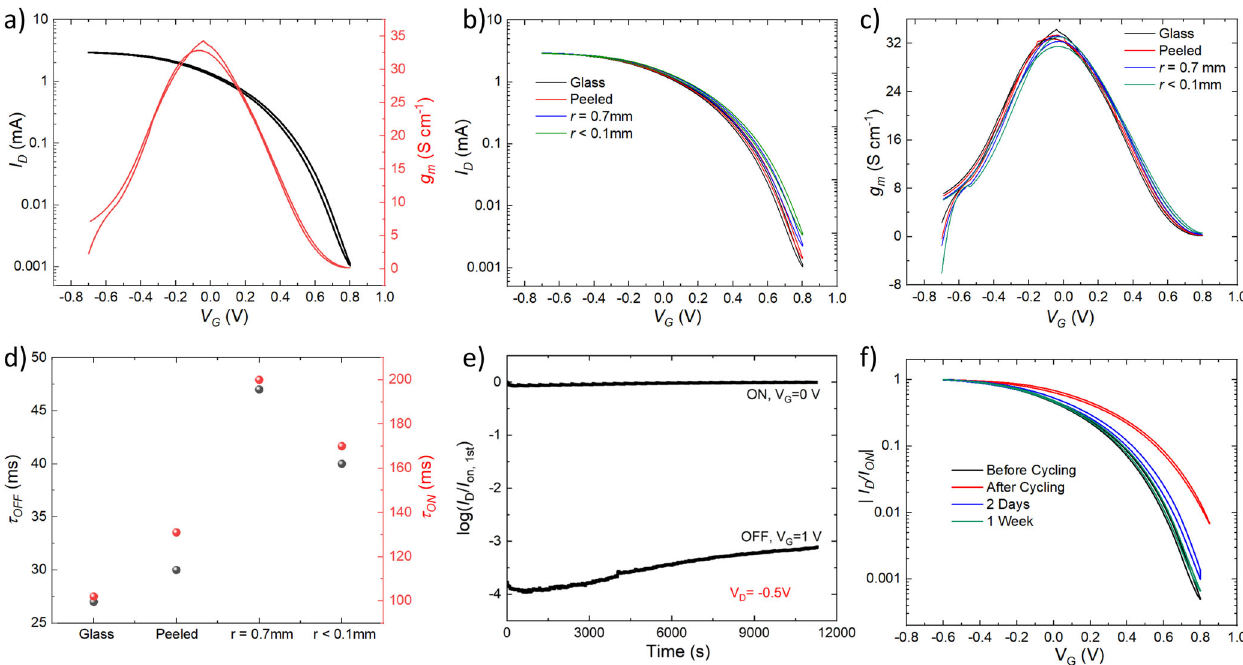
Fig. 2 Electrical characteristics of the 3D-printed OECT. a Transfer curve and normalized transconductance of the 3D-printed OECT. b OECT transfer curves and ( c ) transconductances under different mechanical stress. d OECT response time under different mechanical stress. e OECT electrical stability under V G cycling (0 – 1 V) for over 3 h. f Comparison of the normalized transfer curves before and after cycling stability test and their recovery after resting at 6 °C and high